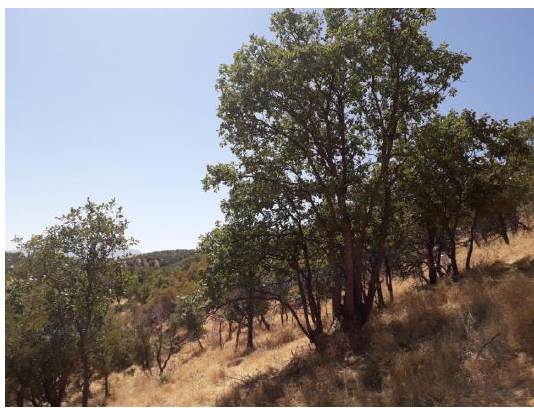
Figure 2. One of the measuring plots shows Brant’s Oak trees locate in a sloped train.